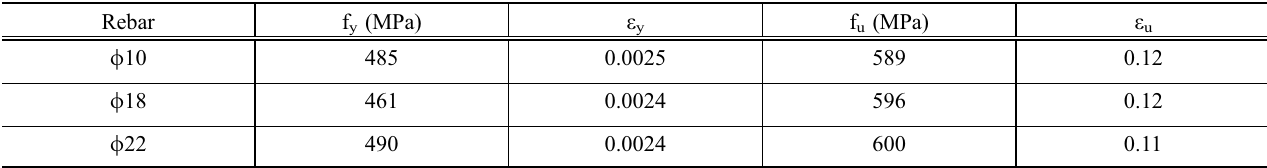
Table 1 Tensile test results for longitudinal and transverse